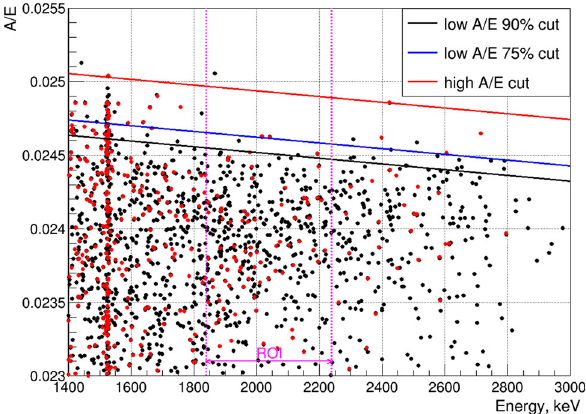
Fig. 12 A/E parameter versus the event energy registered by the BEGe detector in LArGe without NMS. Red dots indicate events removed by coincidence with the LAr veto. Here only the small 42 Ar source is dissolved in liquid argon